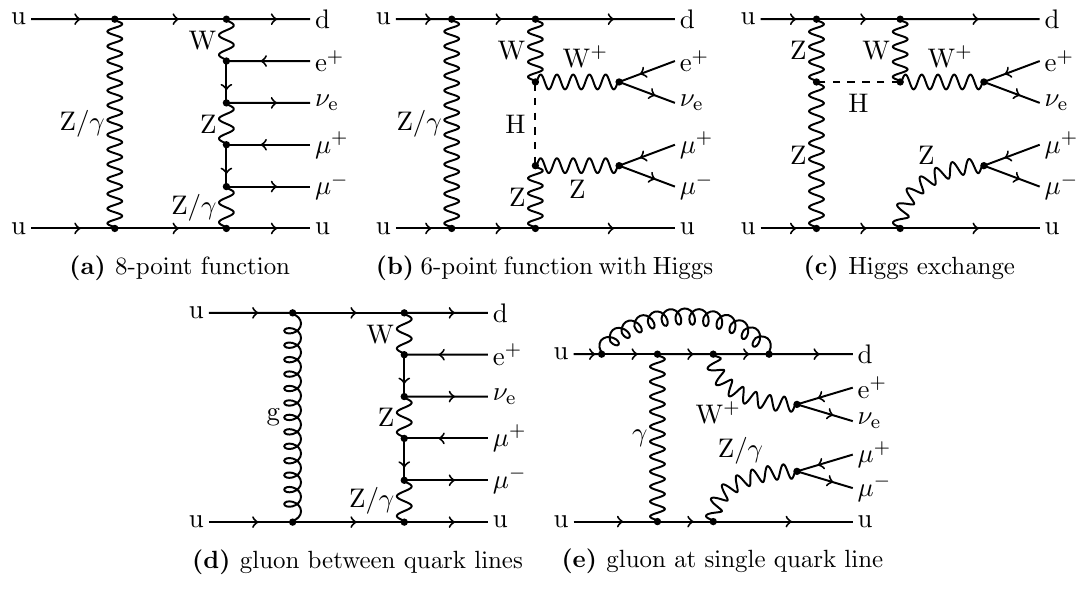
Figure 2. Example loop